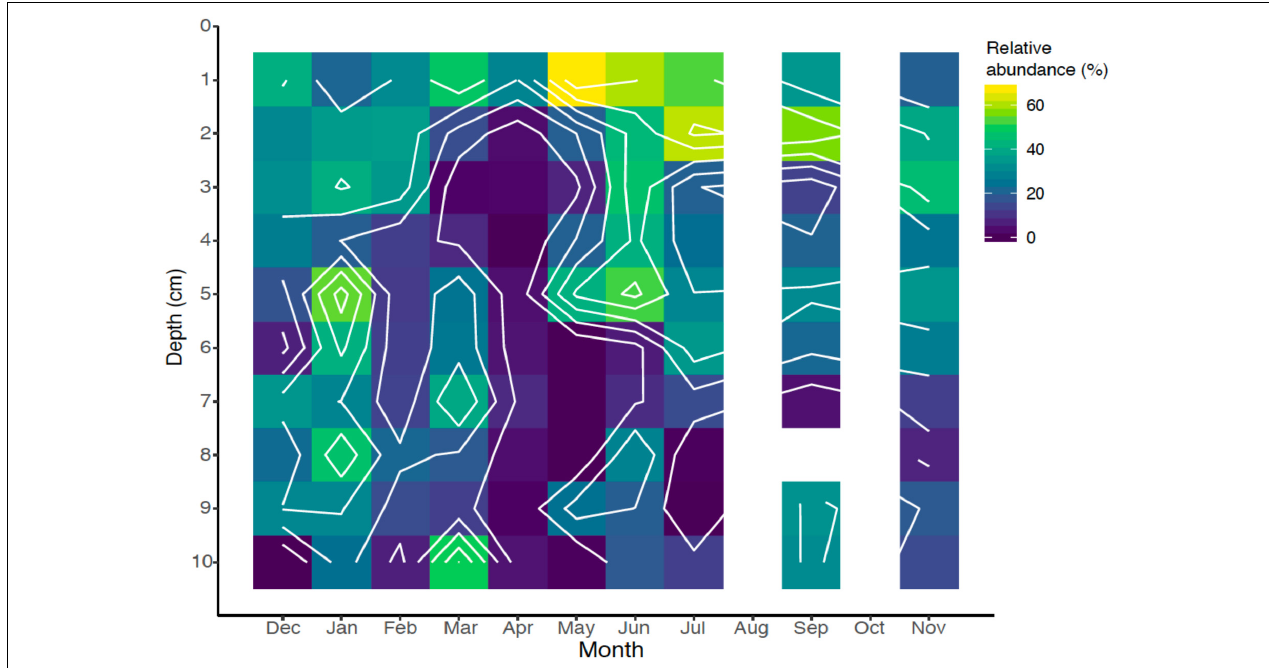
FIGURE 8 | Spatiotemporal relative abundance of nematodes (Nematoda) identified by 18S rRNA gene sequencing over the seasonal cycle.